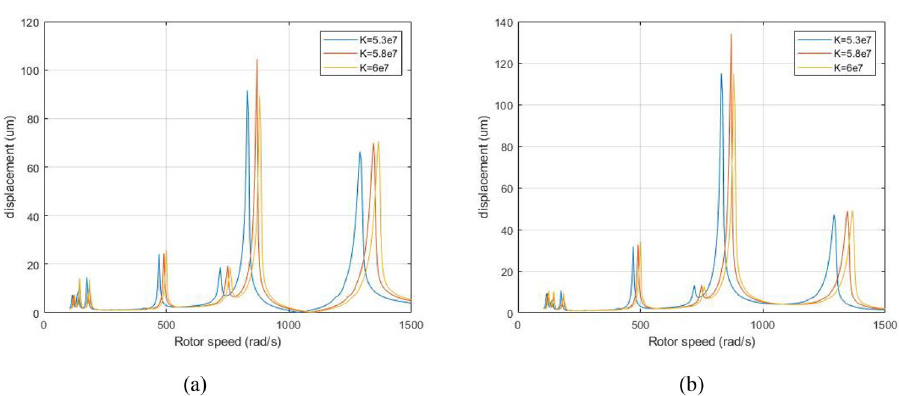
Figure 19. Amplitude-frequency response curve (λ = 1. 75, F 0 = 100, A max = 200) ( a ) LP rotor ( b ) HP